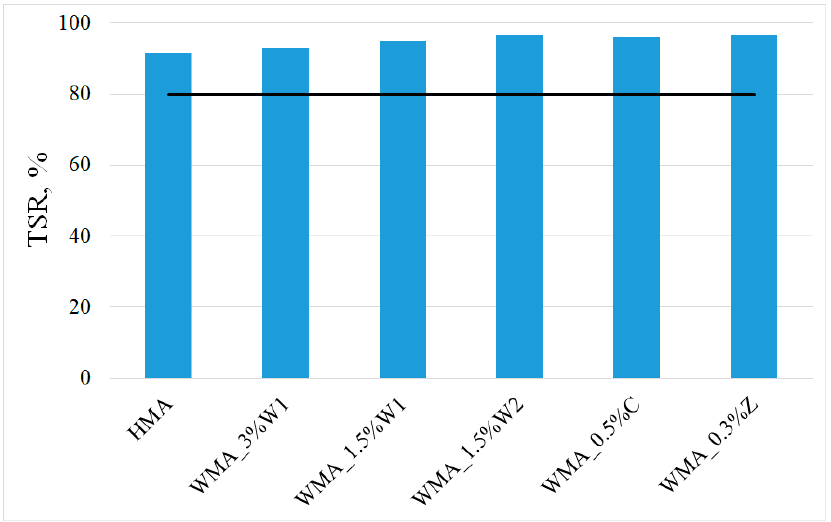
Figure 9. TSR values for different asphalt mixtures.